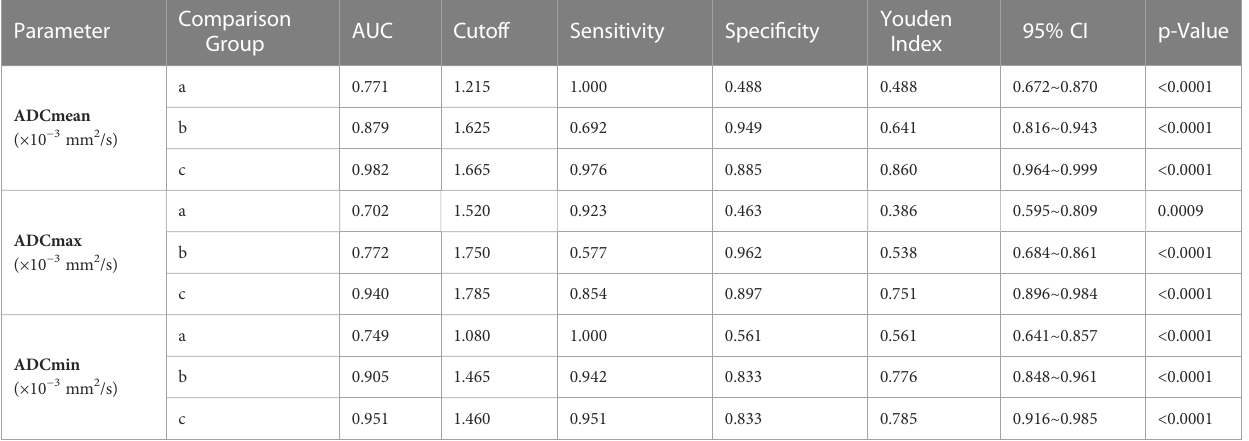
TABLE 2 Diagnostic performance of ADC parameters for classifying